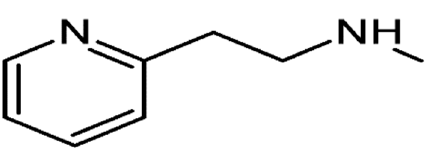
Figure 1. Structure of betahistine .